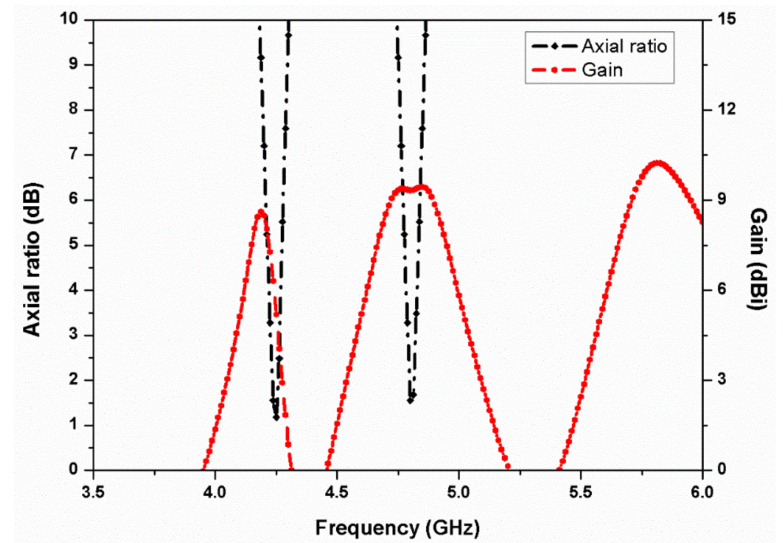
Figure 7. Simulated axial ratio and gain of the two-element stacked MIMO